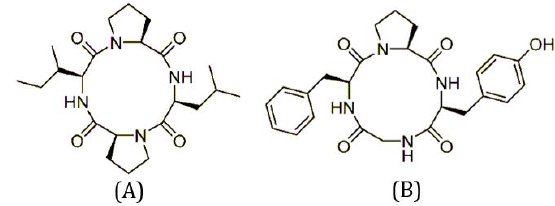
Figure 8. Structures of (A) cyclo-(Leu-Pro-Ile-Pro) and (B) cyclo-(Tyr-Pro-Phe-Gly)